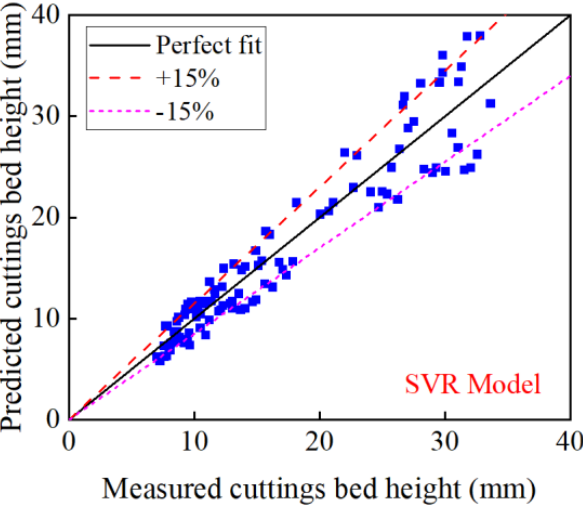
Figure 7. Measured cuttings bed height and predicted cuttings bed height with the SVR model.